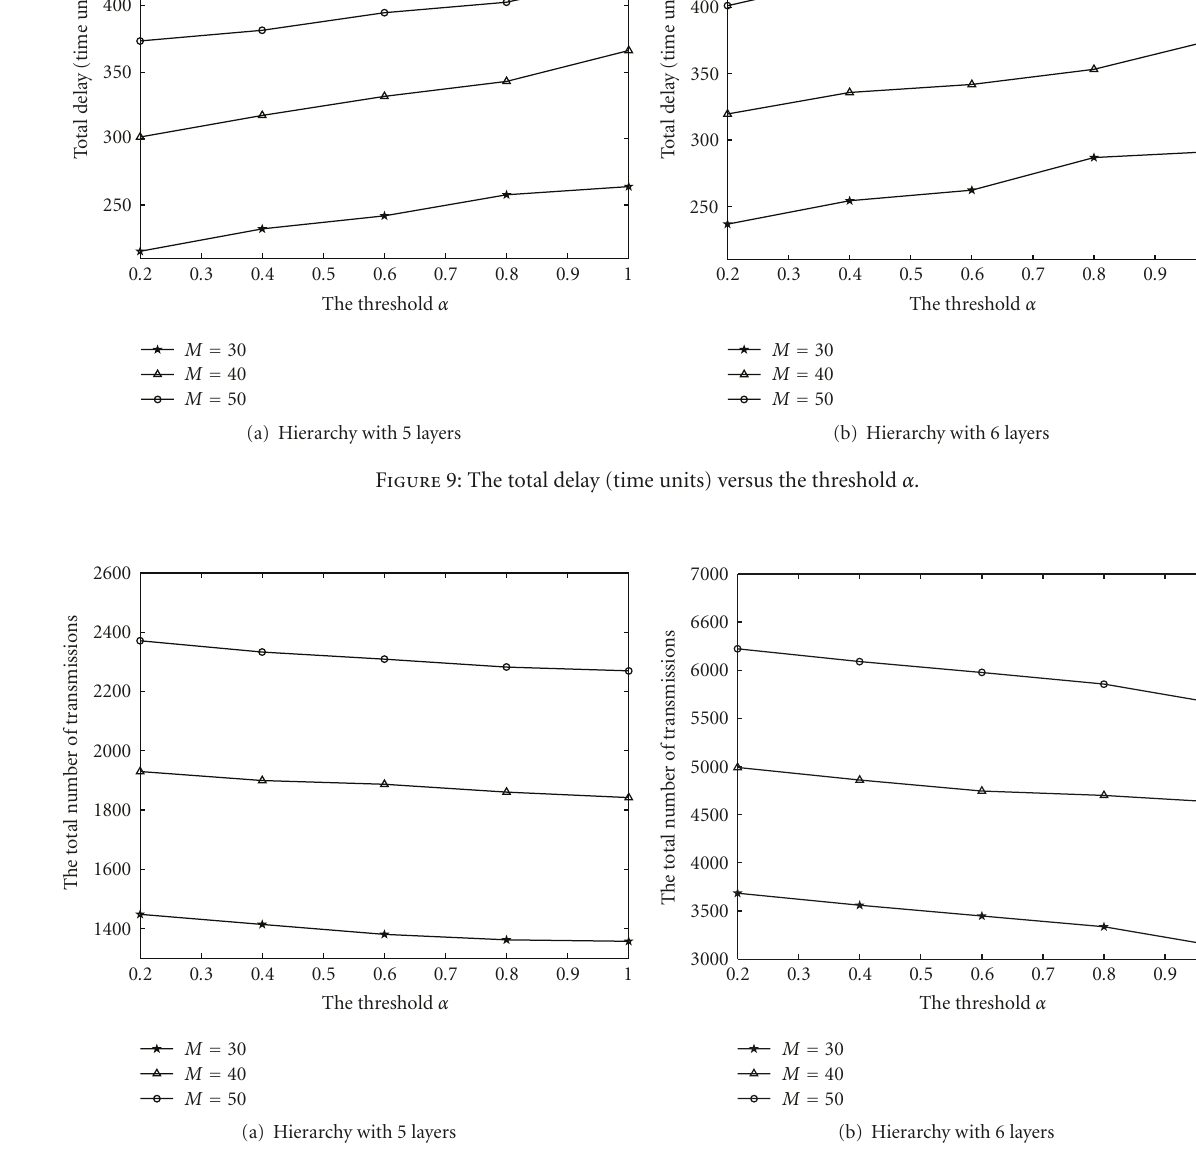
Figure 10: The total number of transmissions required versus the threshold α